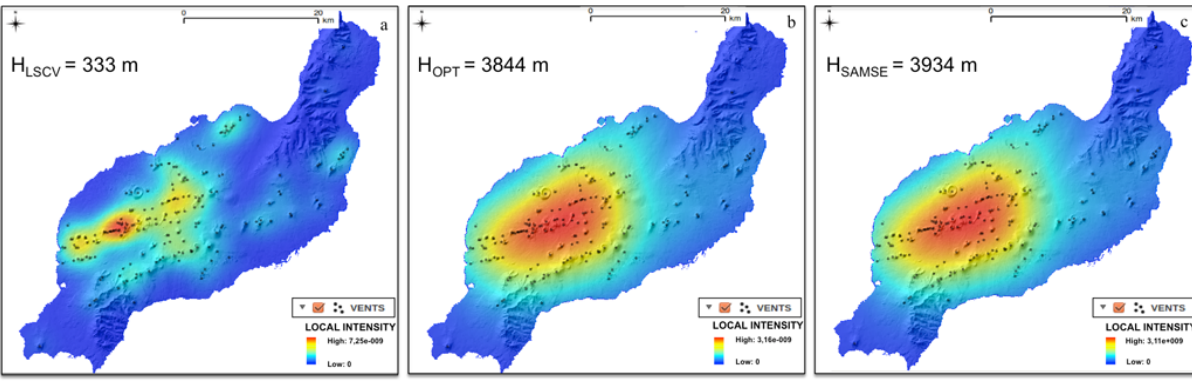
Fig. 9. PDFs of Lanzarote emission centers calculated with the Gaussian kernel using different bandwidths: 333m as computed by the LSCV method (a) , 3844m as by the h opt score (b) , and 3934m as by the SAMSE selector (c)